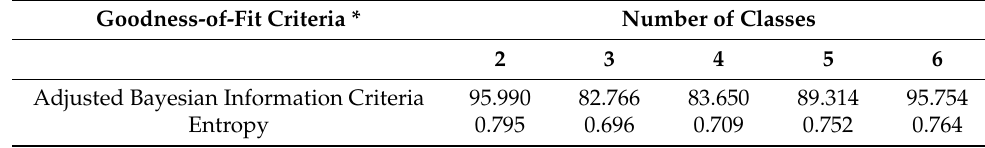
Table 4. Latent class analysis model fit.